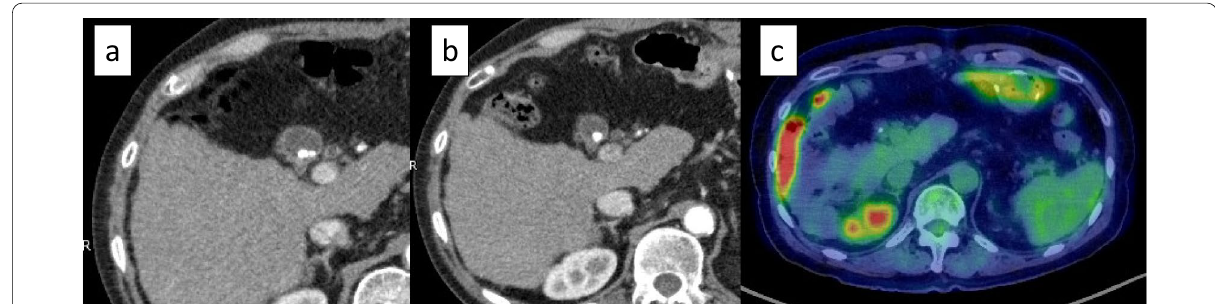
Fig. 3 a CT findings 2 years before the second gastric surgery. b Preoperative CT findings. It was difficult to identify the primary site, and there were no findings suggestive of distant or LN metastasis. There were no abnormal findings in the gallbladder, except for the presence of gallstones, and